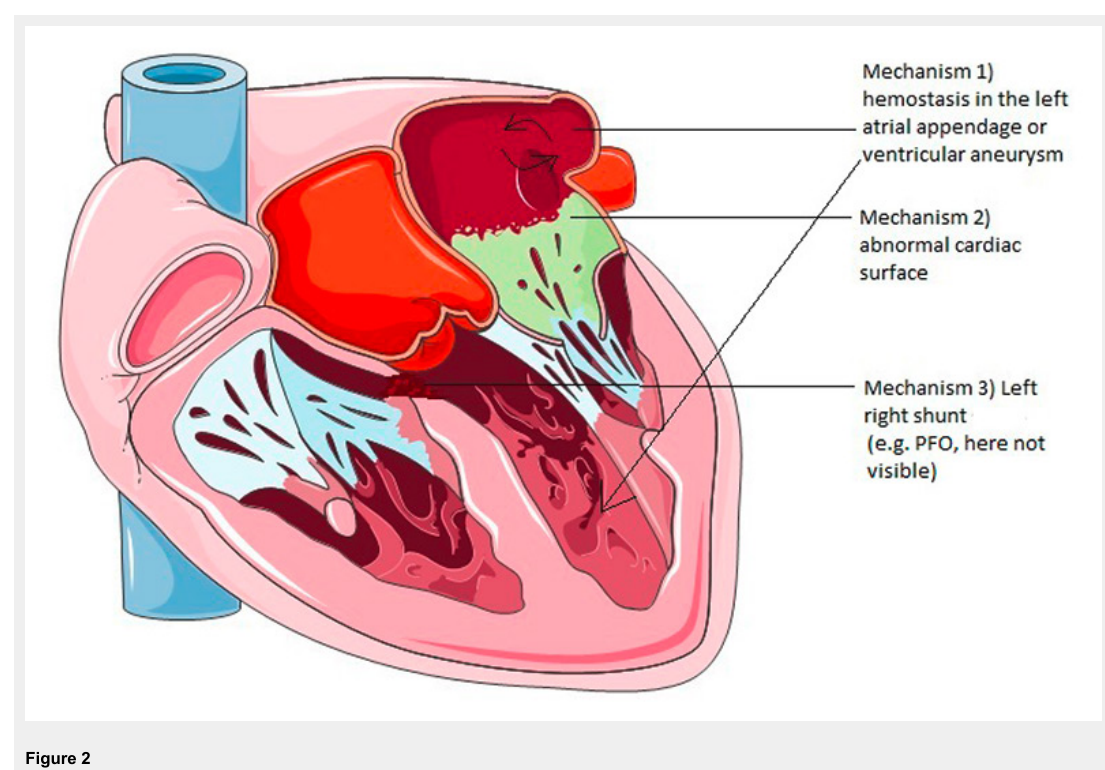
Figure 2 Most important mechanisms for the formation of cardiac embolism (imaging material adapted from Servier Medical Art). PFO = patent foramen